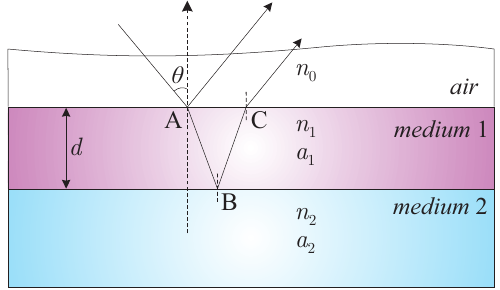
Figure 1. Geometric setup and basic principles of the IRIM.